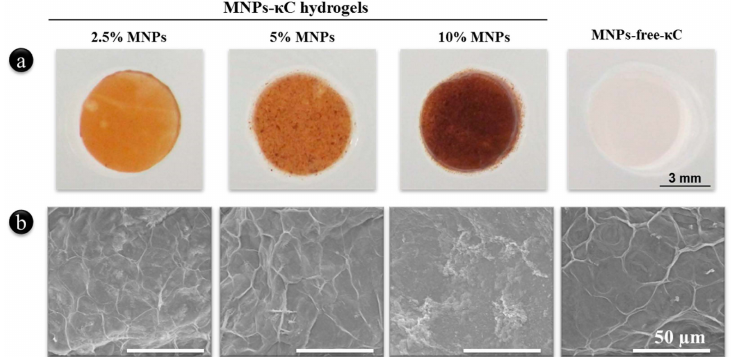
Figure 1. MNPs- κ C hydrogels laden with hASCs in basal culture for 21 days. Macroscopic view of κ C hydrogels loaded with different concentrations of MNPs, namely 2.5%, 5% and 10% ( v / v ), and the experimental control without MNPs, referred as MNPs-free- κ